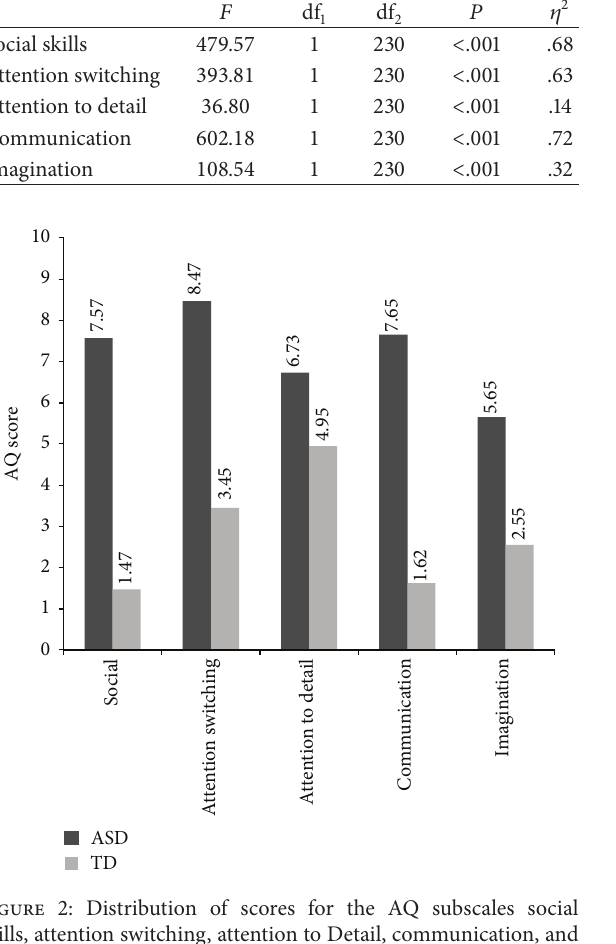
Table4:ANCOVAscomparingTDandASDscoresonthesubscales